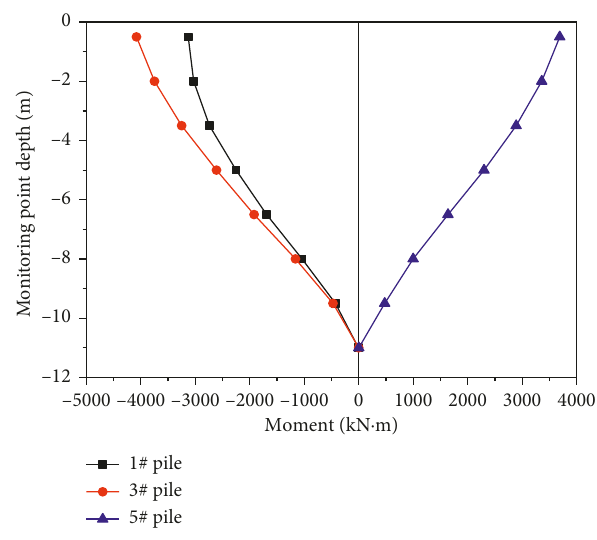
Figure 15: Bending moment envelope of the